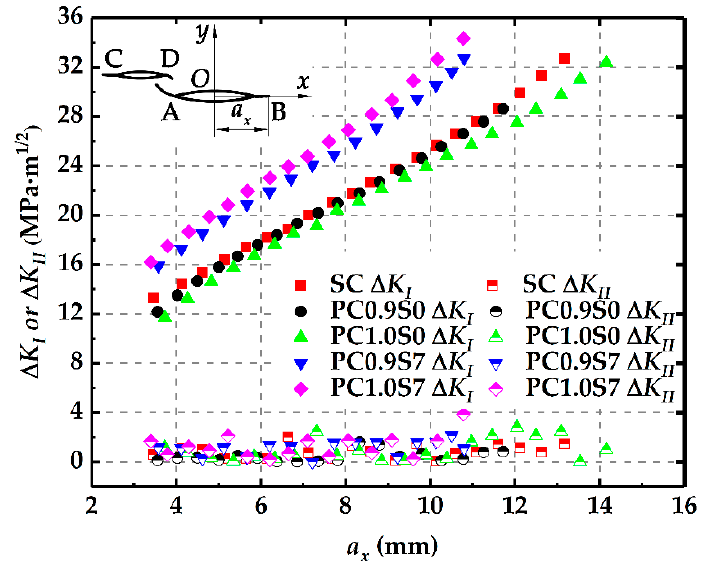
Figure 11. Changes of ∆ K I and ∆ K II at tip B with the increasing a x.